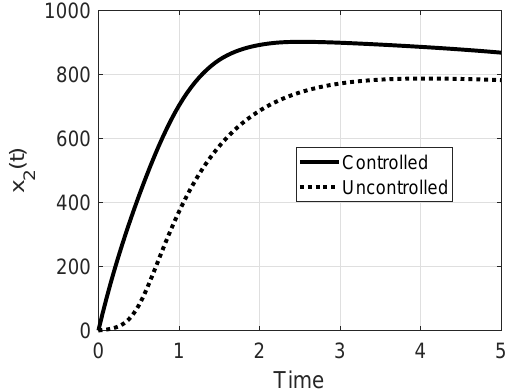
Figure 13. Case 5: evolution of the number of x 2 ( t ) with (continuous line) and without control (dotted